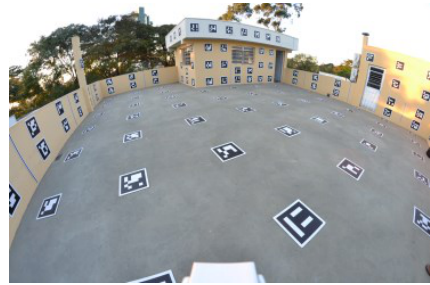
Figure 5. Example of one image of the calibration field with ARUCO coded